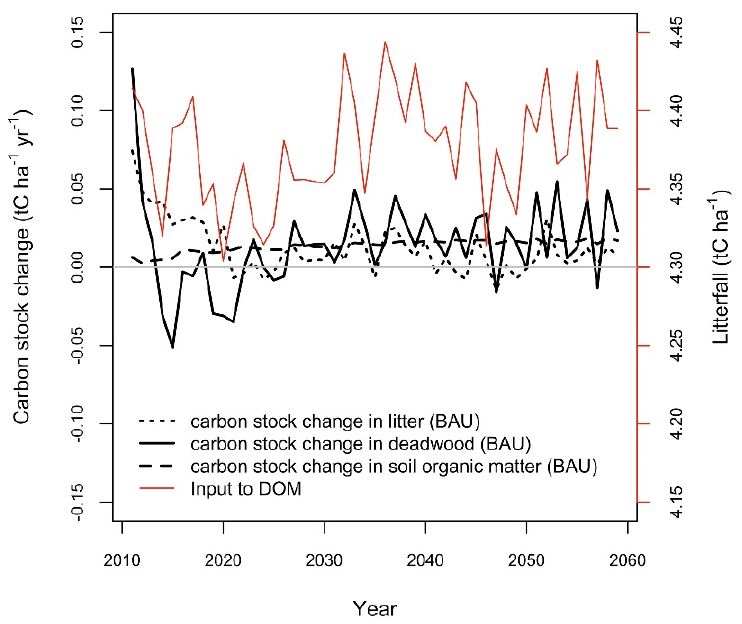
Figure 9. Simulated C stock change in each C subpool and litterfall by CBM for one climatic region for BAU scenario. The values presented are averaged for all eight forest types.